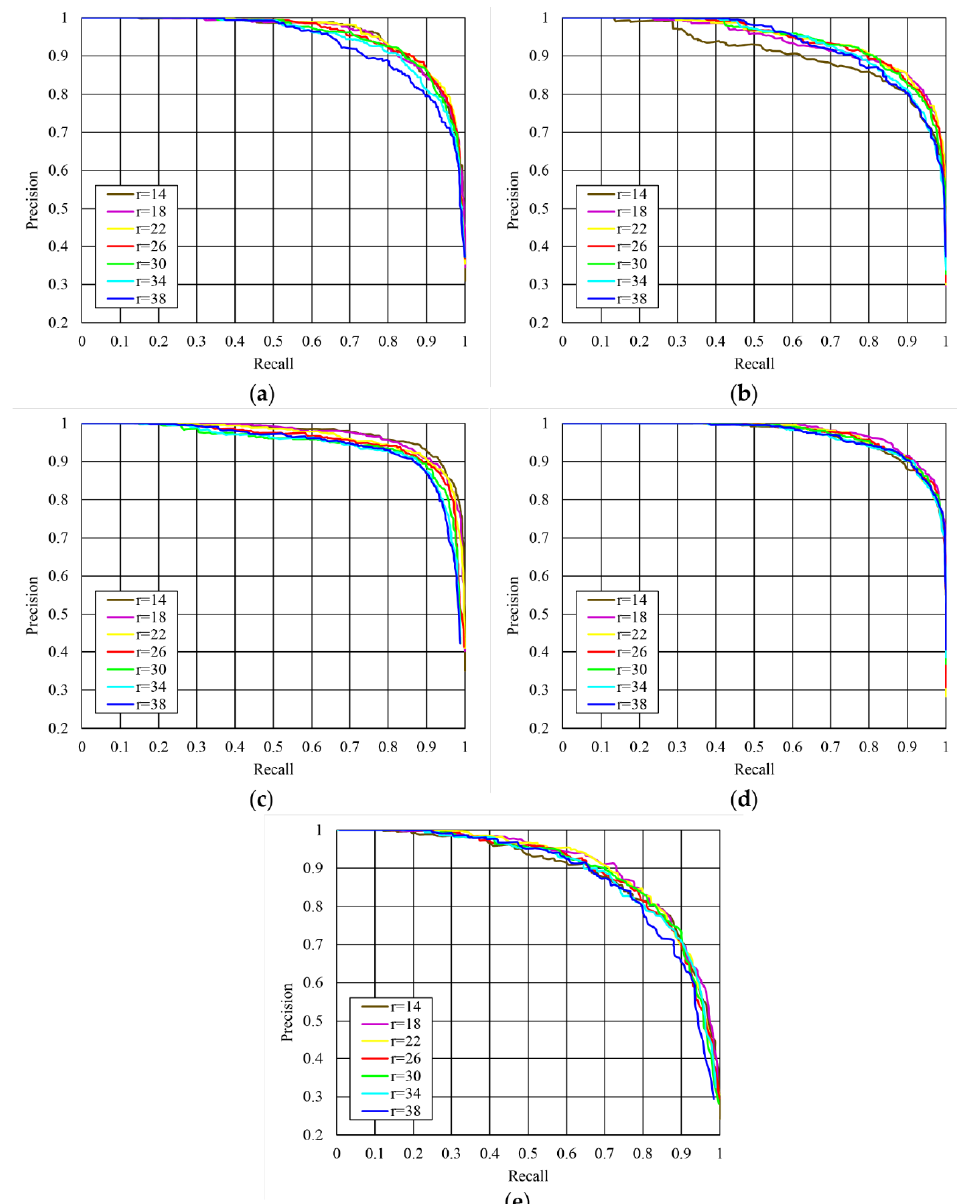
Figure 8. Built-up areas predication performance under different r . ( a ) The precision–recall curves of R1, where the average size of buildings is 13 pixels; ( b ) The precision–recall curves of R2, where the average size of buildings is 13 pixels; ( c ) The precision–recall curves of R3, where the average size of buildings is 12 pixels; ( d ) The precision–recall curves of R4, where the average size of buildings is 13 pixels; ( e ) The precision–recall curves of R5, where the average size of buildings is 12 pixels.